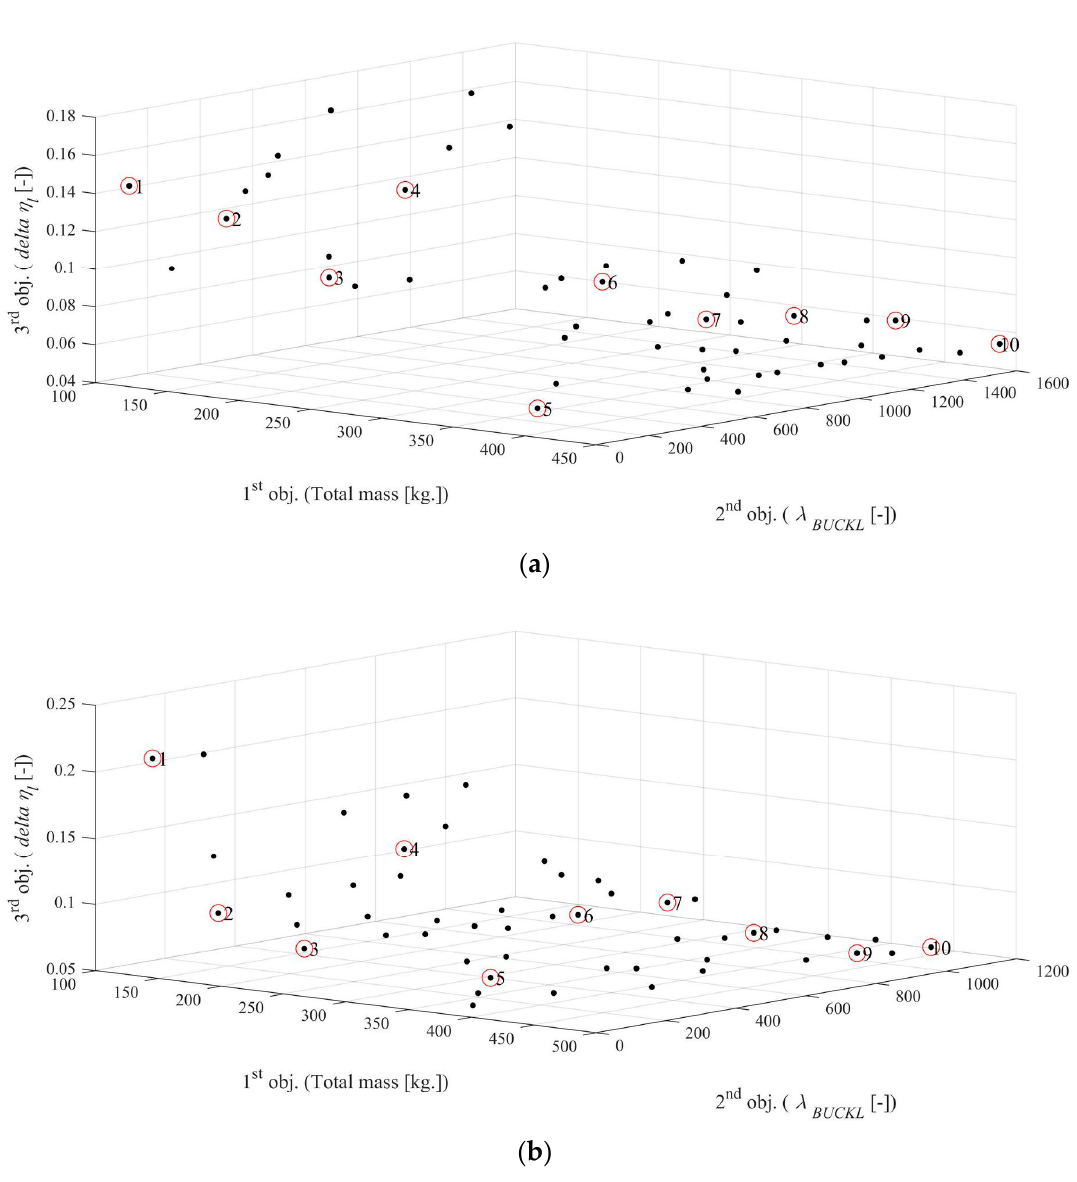
Figure 9. Pareto frontier and the 10 selected solutions for ( a ) Case. I. and ( b ) Case. II. Table 2. Objective and constraint functions of some selected Pareto solution set from Figure 8a for Case I. Pareto Front No.